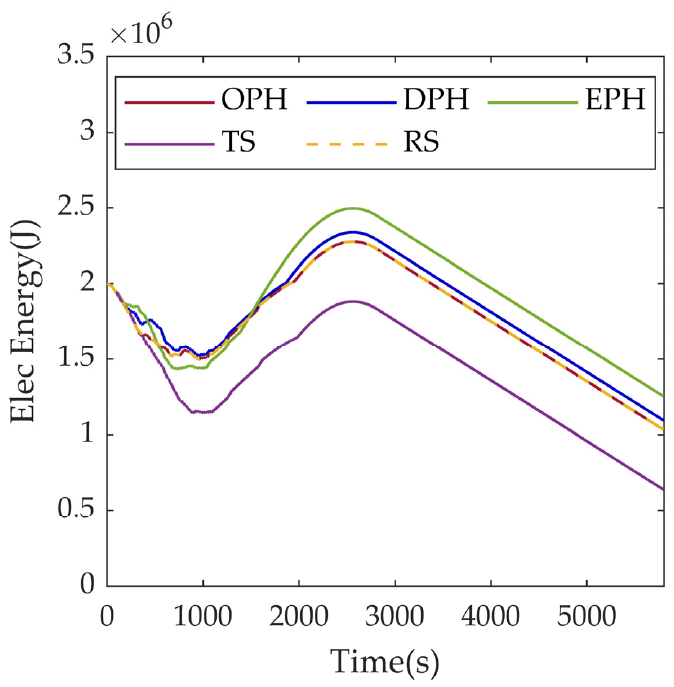
Figure 9. Satellite electrical energy diagram of a single condition in the first group.